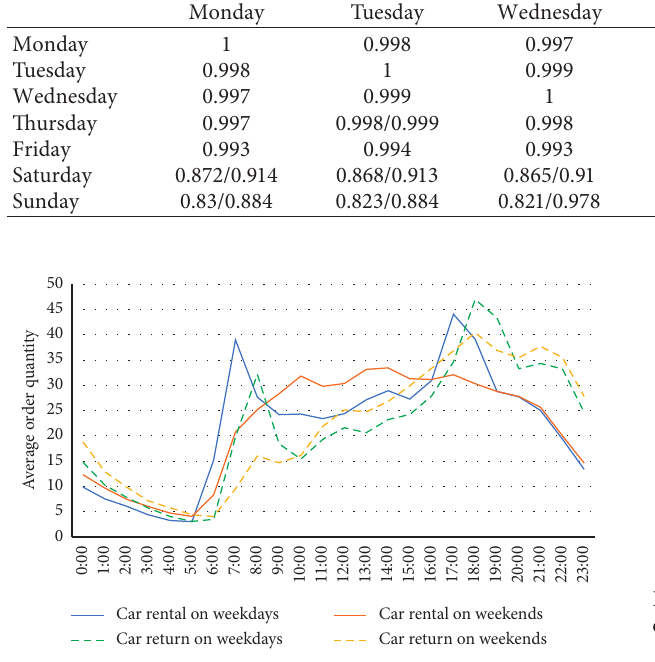
Figure 4: Average rental and return distribution on the time axis of one day for weekdays and